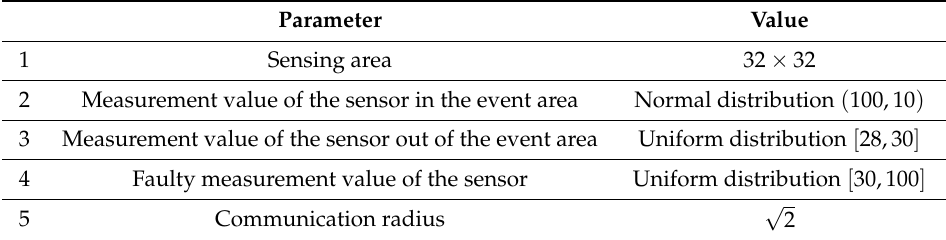
Table 2. Experimental